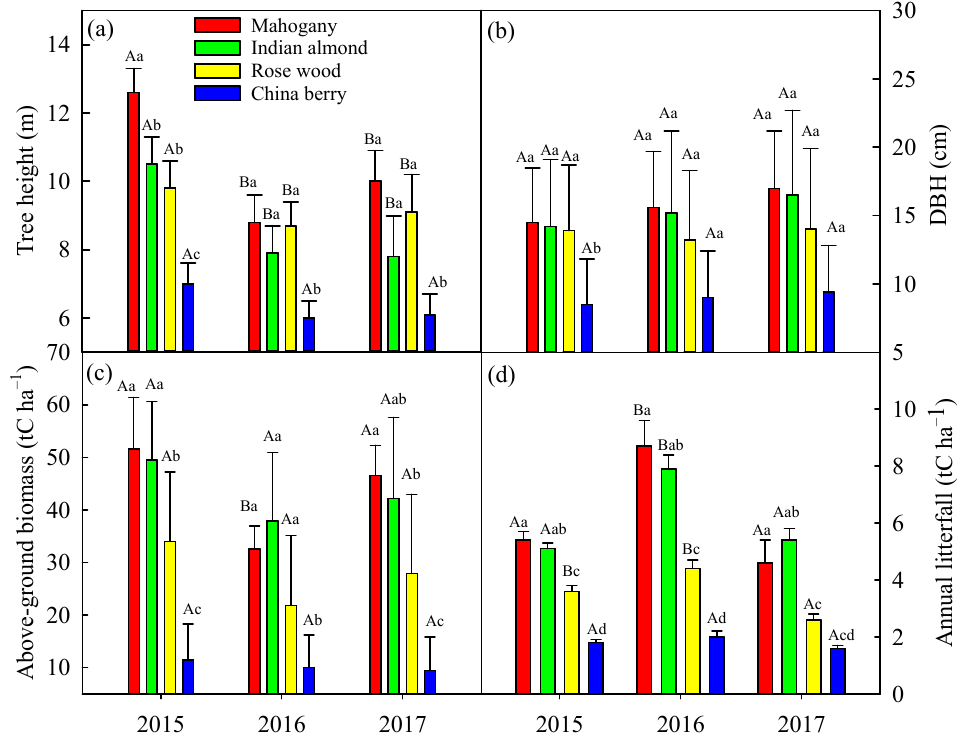
Figure 2. Interannual variations in ( a ) tree height, ( b ) DBH, ( c ) aboveground biomass, and ( d ) annual litterfall from 2015 to 2017 for different tree species: mahogany ( Swietenia macrophylla King, red bar), Indian almond ( Terminalia catappa Linn., green bar), rose wood ( Pterocarpus indicus Willd., yellow bar), and China berry ( Melia azedarach Linn., blue bar). Different capital letters indicate differences among years for the same species at p < 0.05. Different lowercase letters indicate differences among species within the same years at p < 0.05. Error bars indicate standard deviations ( n = 4) .